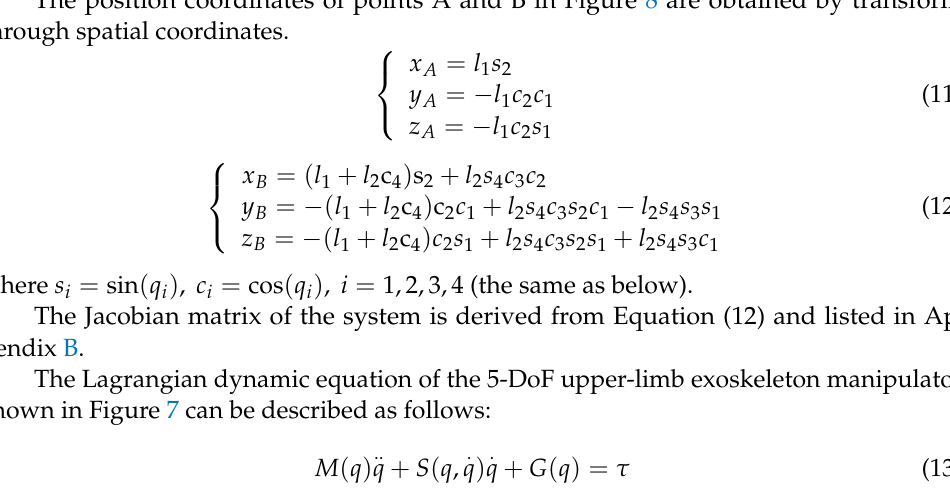
Figure 8. Simplified sketch of exoskeleton manipulator coordinate system.